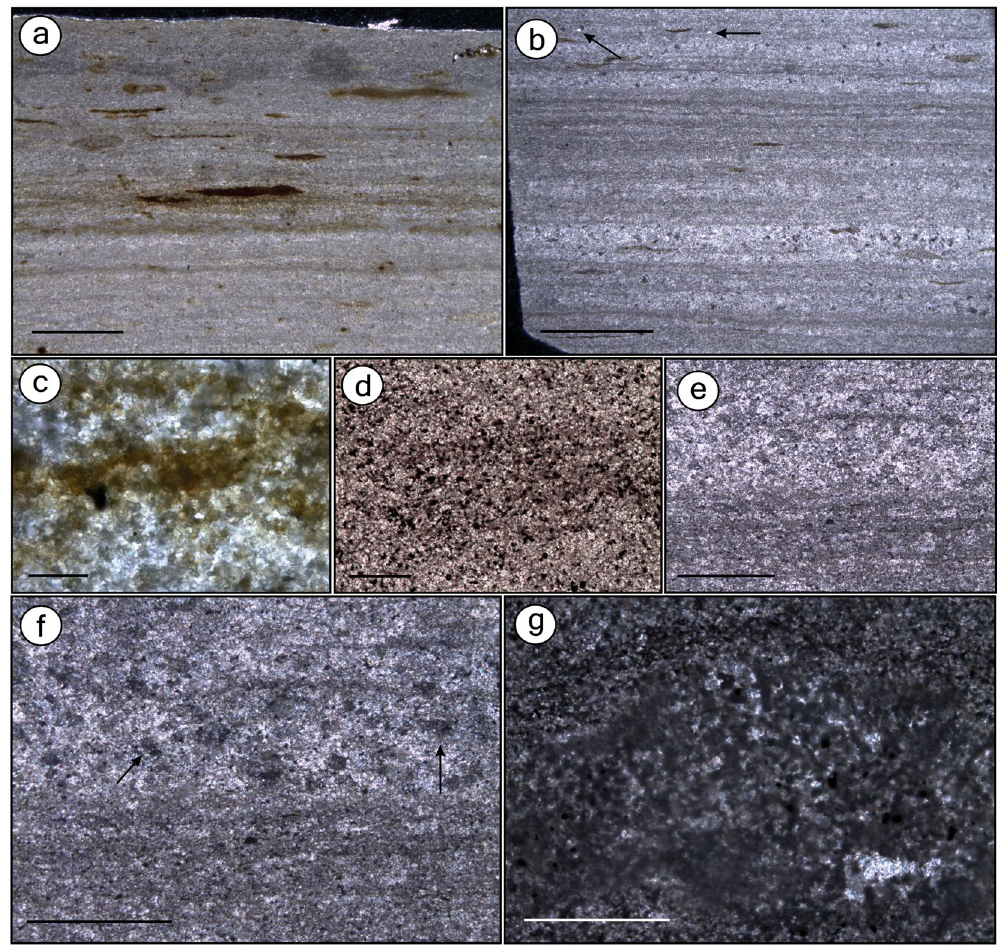
Figure 1. Thin sections of the beige limestone (BL) and the grey limestone (GL) microfacies. Thin sections GP/L 21 ( a , d ), GP/L 19 ( b ), GP/L 18 ( g ), GP/L 172 ( c ), and GP/L 16 ( e , f ). (a ) BL is composed of thin laminasets of diffuse dark clay laminae (detail in c ), interlaminated with pale pure microspar laminae. Elongated to round organic matter-rich dark lenses 11 are indistinctly scattered. This microfacies is interpreted as the laminated limestone (LL) Sm5 microfacies 12 . ( b ) GL is composed of dark-grey undulated laminasets formed by thin laminae with fine blackish scattered material, likely clay/organic matter impurities 10, 12 (detail in d ). Laminasets are interlaminated with paler microspar-dominated laminae. Scattered non-oriented detrital quartz is indicated by arrow. GL microfacies is interpreted as Sm1, a clay-carbonate rythmite (CCR) 12 . Besides GL having significantly fewer dark lenses than BL, the clay/organic matter-rich laminasets are more frequent, regularly distributed, thicker and have more and closer-packed laminae. ( c) Detail of BL dark laminae. ( d) Detail of GL dark laminae, showing concentration of pyrite 10 . ( e) Thin section of GL depicting microspar-dominated level (top) and clay-rich laminaset (bottom). ( f) Image in ( e) with crossed-nicols showing neomorphic sparry crystals (arrows). ( g) GL clay-rich level with peloids. Scale bars: ( a) – 1 mm; ( b) – 2 mm; ( c) – 0.02 mm; ( d) – 0.1 mm; ( e) – 0.5 mm; ( f) – 0.5 mm; ( g) – 0. 2